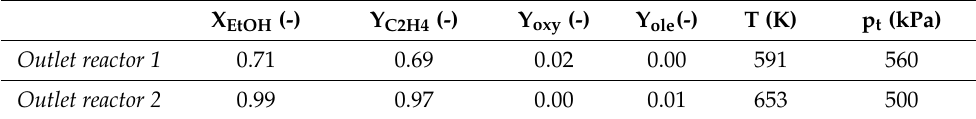
Table 4. Performance results, i.e., conversion (X EtOH ), ethene, oxygenates, and C 3 + olefin yield (respectively, Y C2H4 , Y oxy , Y ole ), temperature (T), and pressure (p t ), as described in Coupard et al. [6]. X EtOH (-) Y C2H4